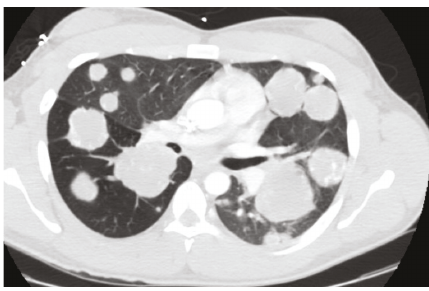
Figure 1: CT chest with pulmonary metastatic disease in a “ cannonball ”